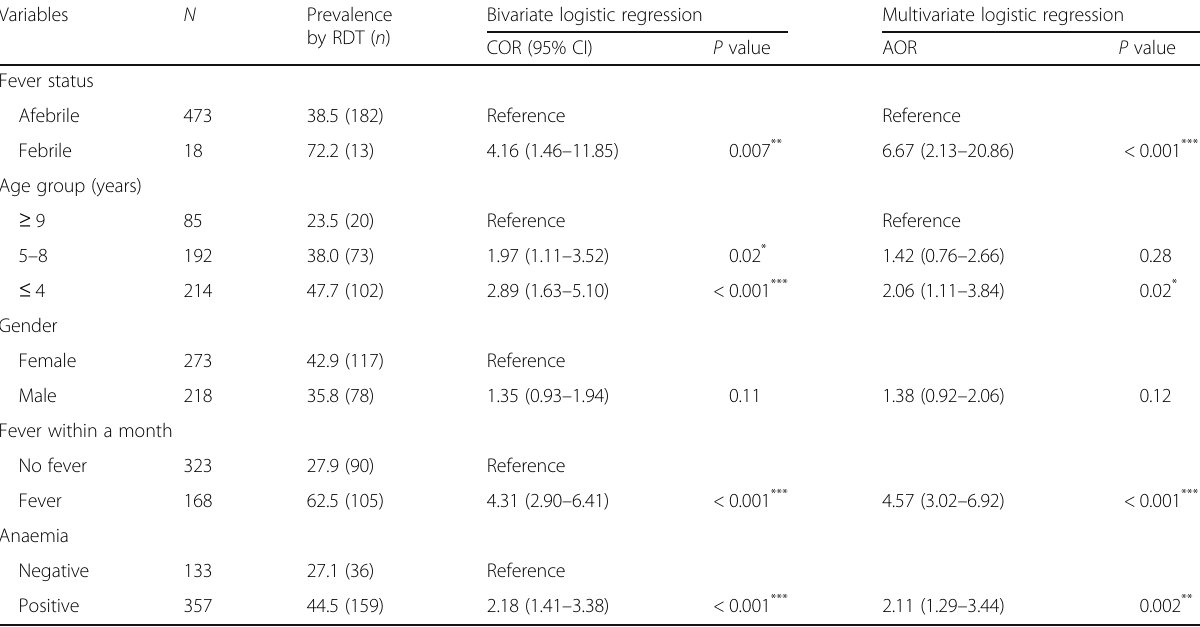
Table 5 Logistic regression model examining factors associated with malaria RDT positivity